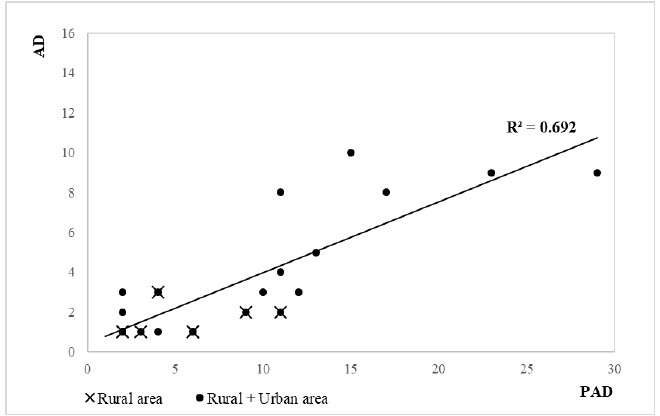
Figure 9. Relationship between private access density (PAD R+U ) and accident density (AD). Table 6. R 2 values for private access density (rural and urban areas) vs. accident indicators. Road Accident Indicators Private